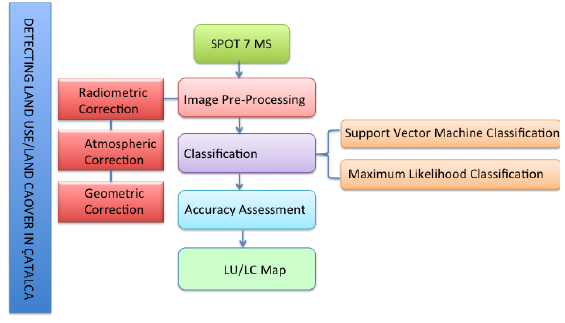
Figure 2. Flowchart of the study In the image pre- processing stage radiometric and atmospheric correction were applied. Digital number values for the SPOT 7 satellite image were converted to radiance values and FLAASH Atmospheric Correction Model was used for atmospheric correction. Scene center location (lat/lon), sensor type, sensor altitude (km), ground elevation (km), pixel size (m), flight date, flight time GMT (HH:MM:SS), atmospheric model, aerosol model, initial visibility (km) were used as input parameters in the model. SPOT 7 image was geometrically corrected by image-to-map registration using 1:5000 scaled topographic maps and orthophotos. It took into consideration to be homogeneously distributed on the image of the selected control points.